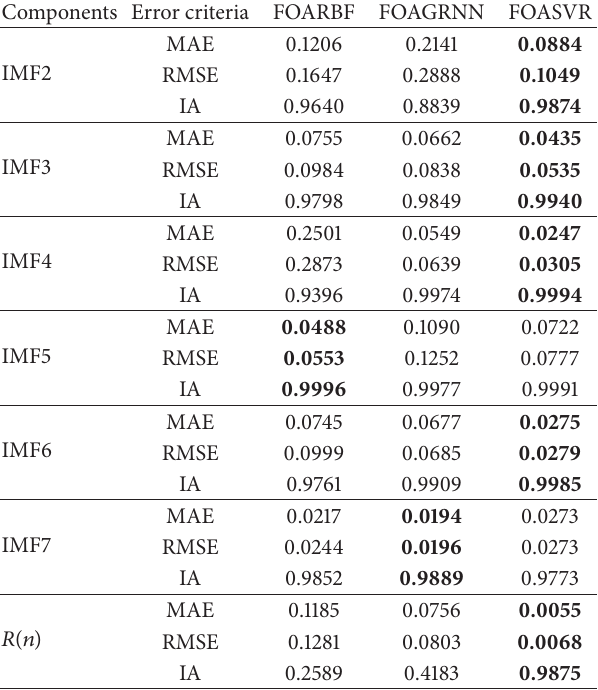
Table 6: The forecasting results of model selection among the FOARBF, FOAGRNN, and FOASVR in autumn.